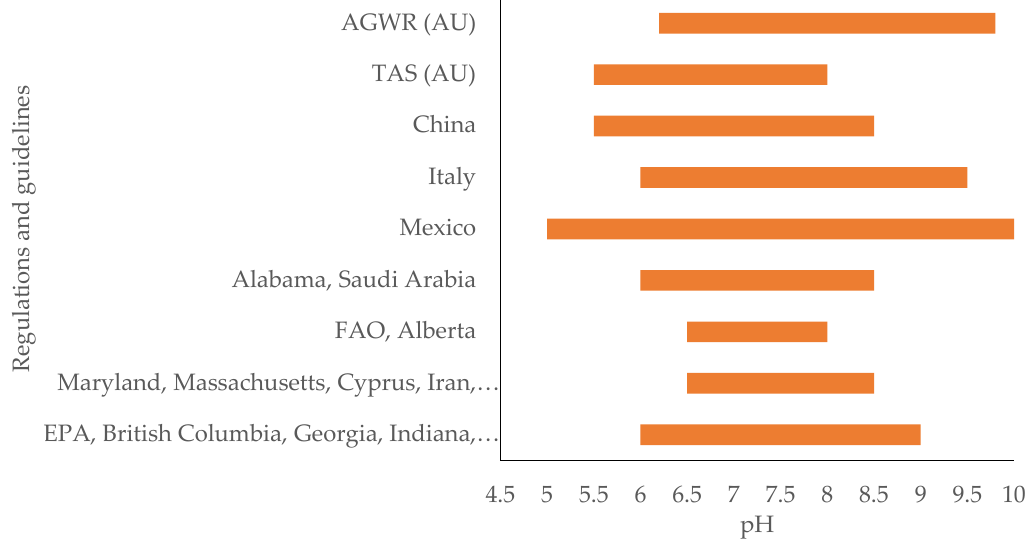
Figure 2. Required pH ranges in agricultural water reuse regulations and guidelines.